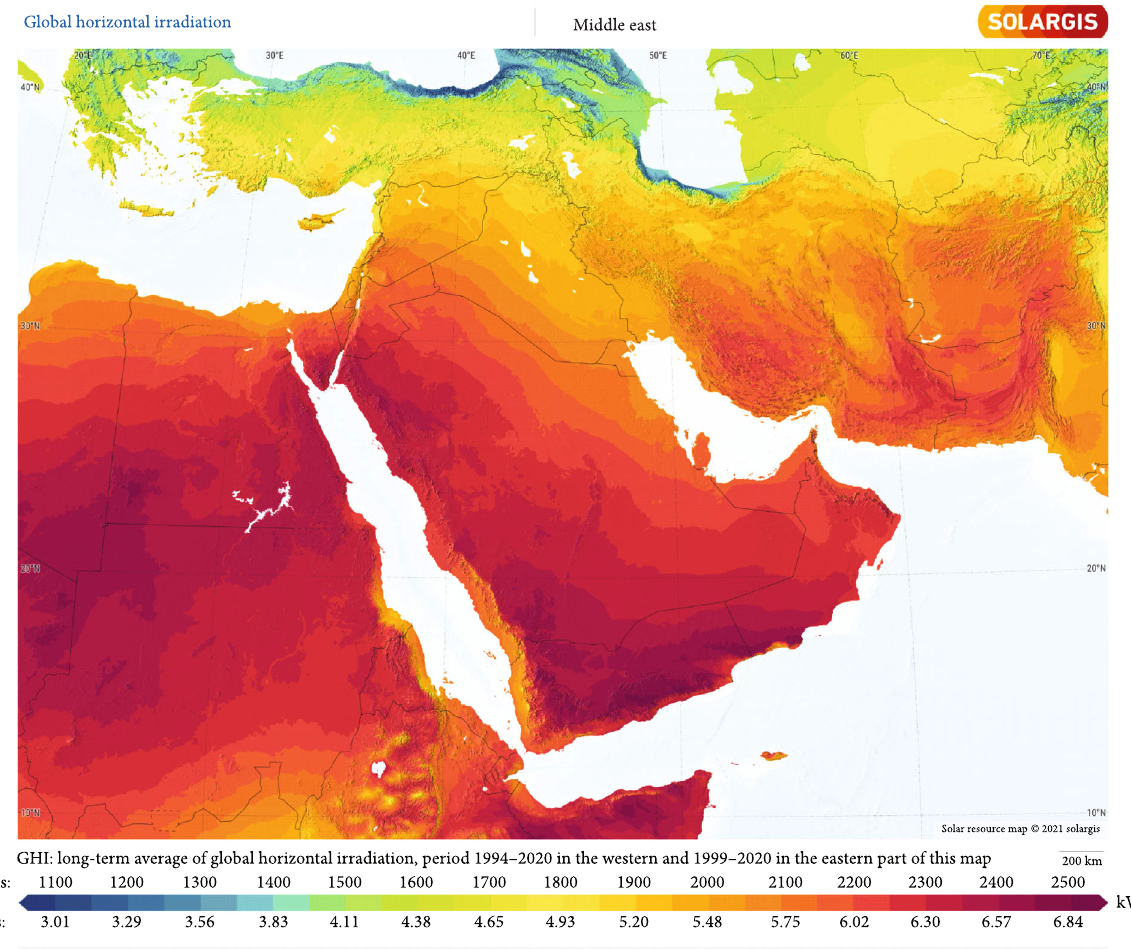
Figure 2: The intensity of horizontal solar radiation in the Middle East